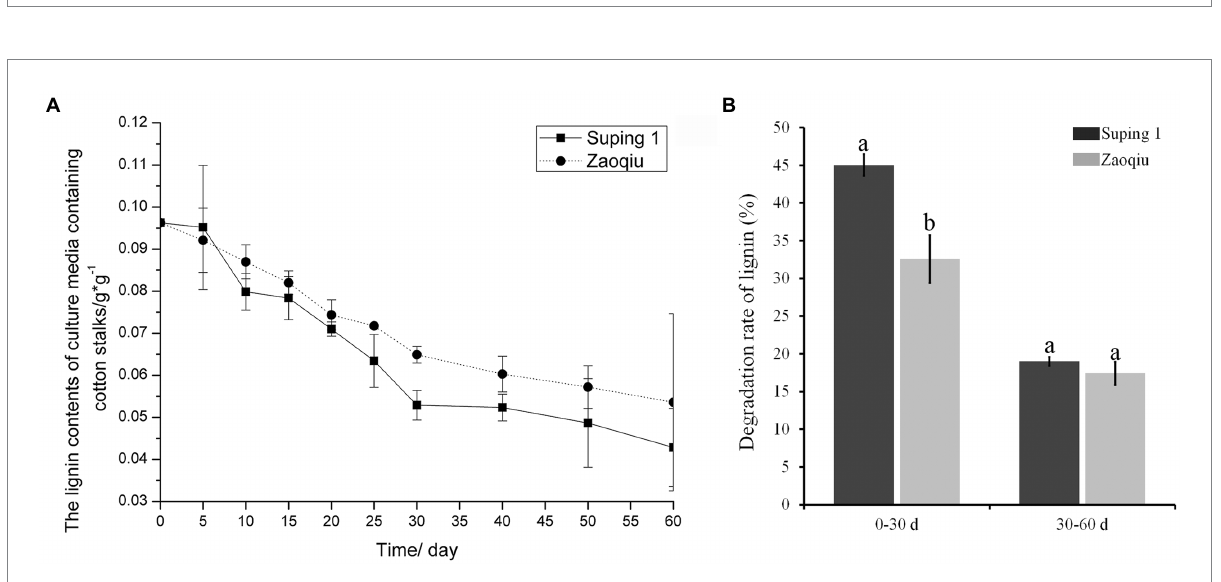
FIGURE 2 Dynamic monitoring of lignin content in cotton stalk medium inoculated with P. ostreatus strains (Suping 1 and Zaoqiu). (A) Changes of lignin content in cotton stalks medium after inoculation. (B) Degradation rates of cotton stalk lignin by Suping 1 and Zaoqiu at various stages. The different letters in the same pillars indicate significant differences according to the LSD at p ≤ 0.05